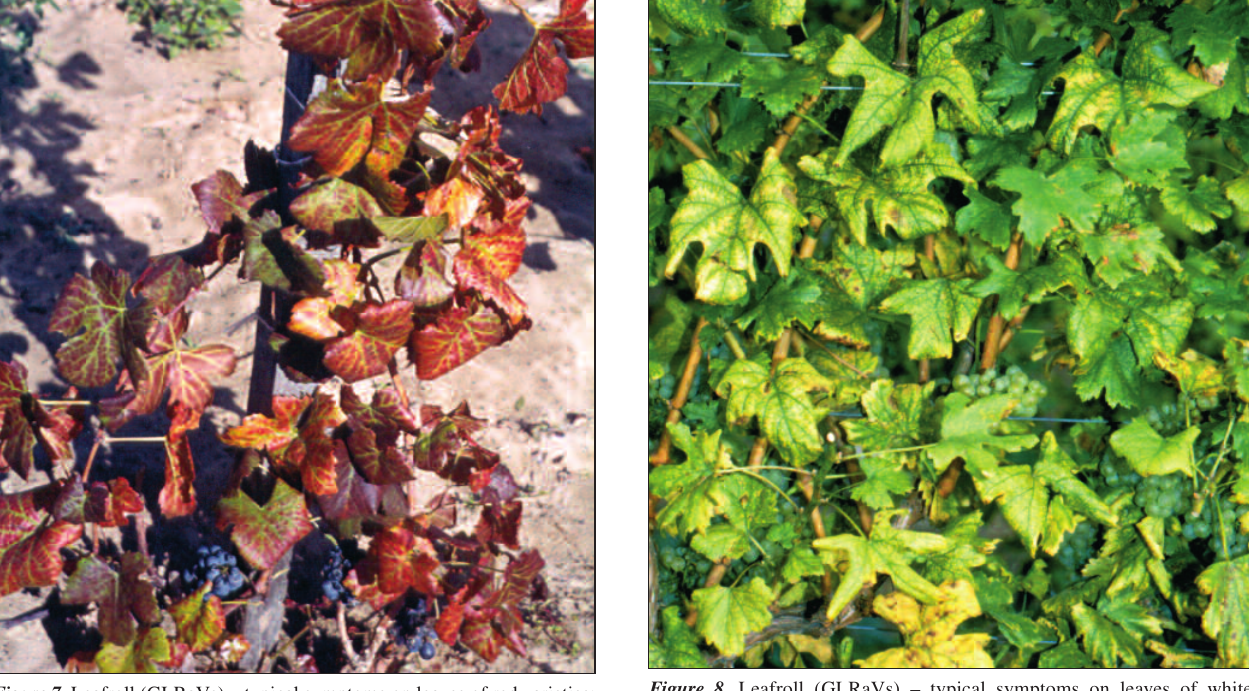
Figure 7. Leafroll (GLRaVs) – typical symptoms on leaves of red varieties: rolling and reddening